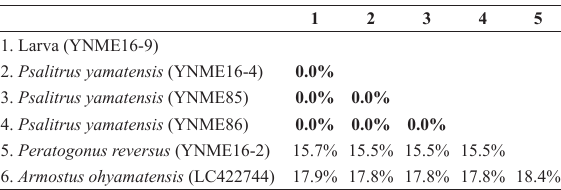
Table 2. Pairwise distances between individuals in analysis ex - pressed as a percentage of nucleotide differences ( p